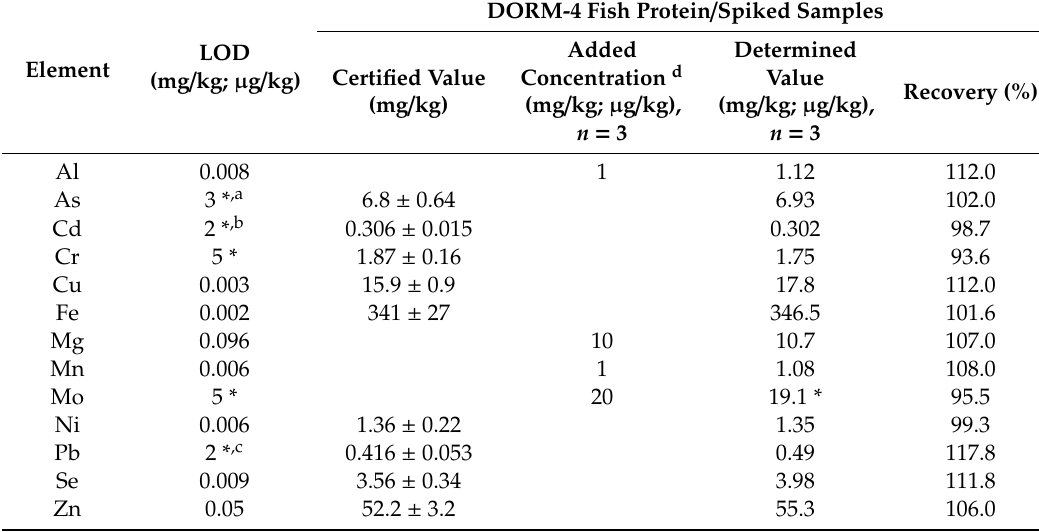
Table 2. Limits of detection (LOD) of elements and quality control of results using the certified reference material (DORM-4 fish protein) and spiked